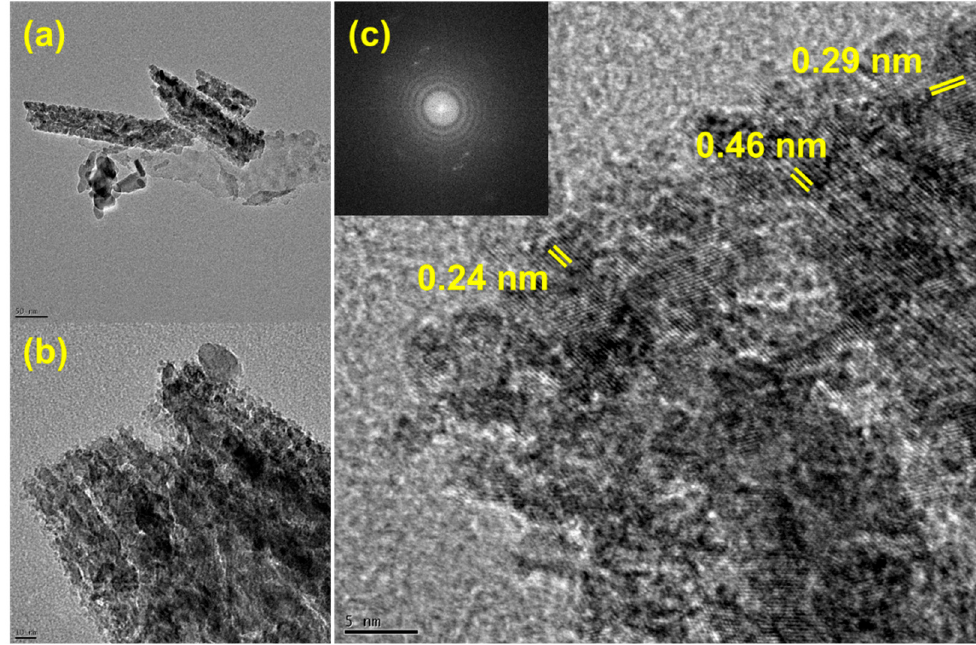
Figure 4. ( a , b ) TEM images at different magnifications, ( c ) high-resolution TEM image of Co 3 O 4 @Mo-Co 3 O 4 needle-like nanosheet heterostructure: inset SAED pattern.